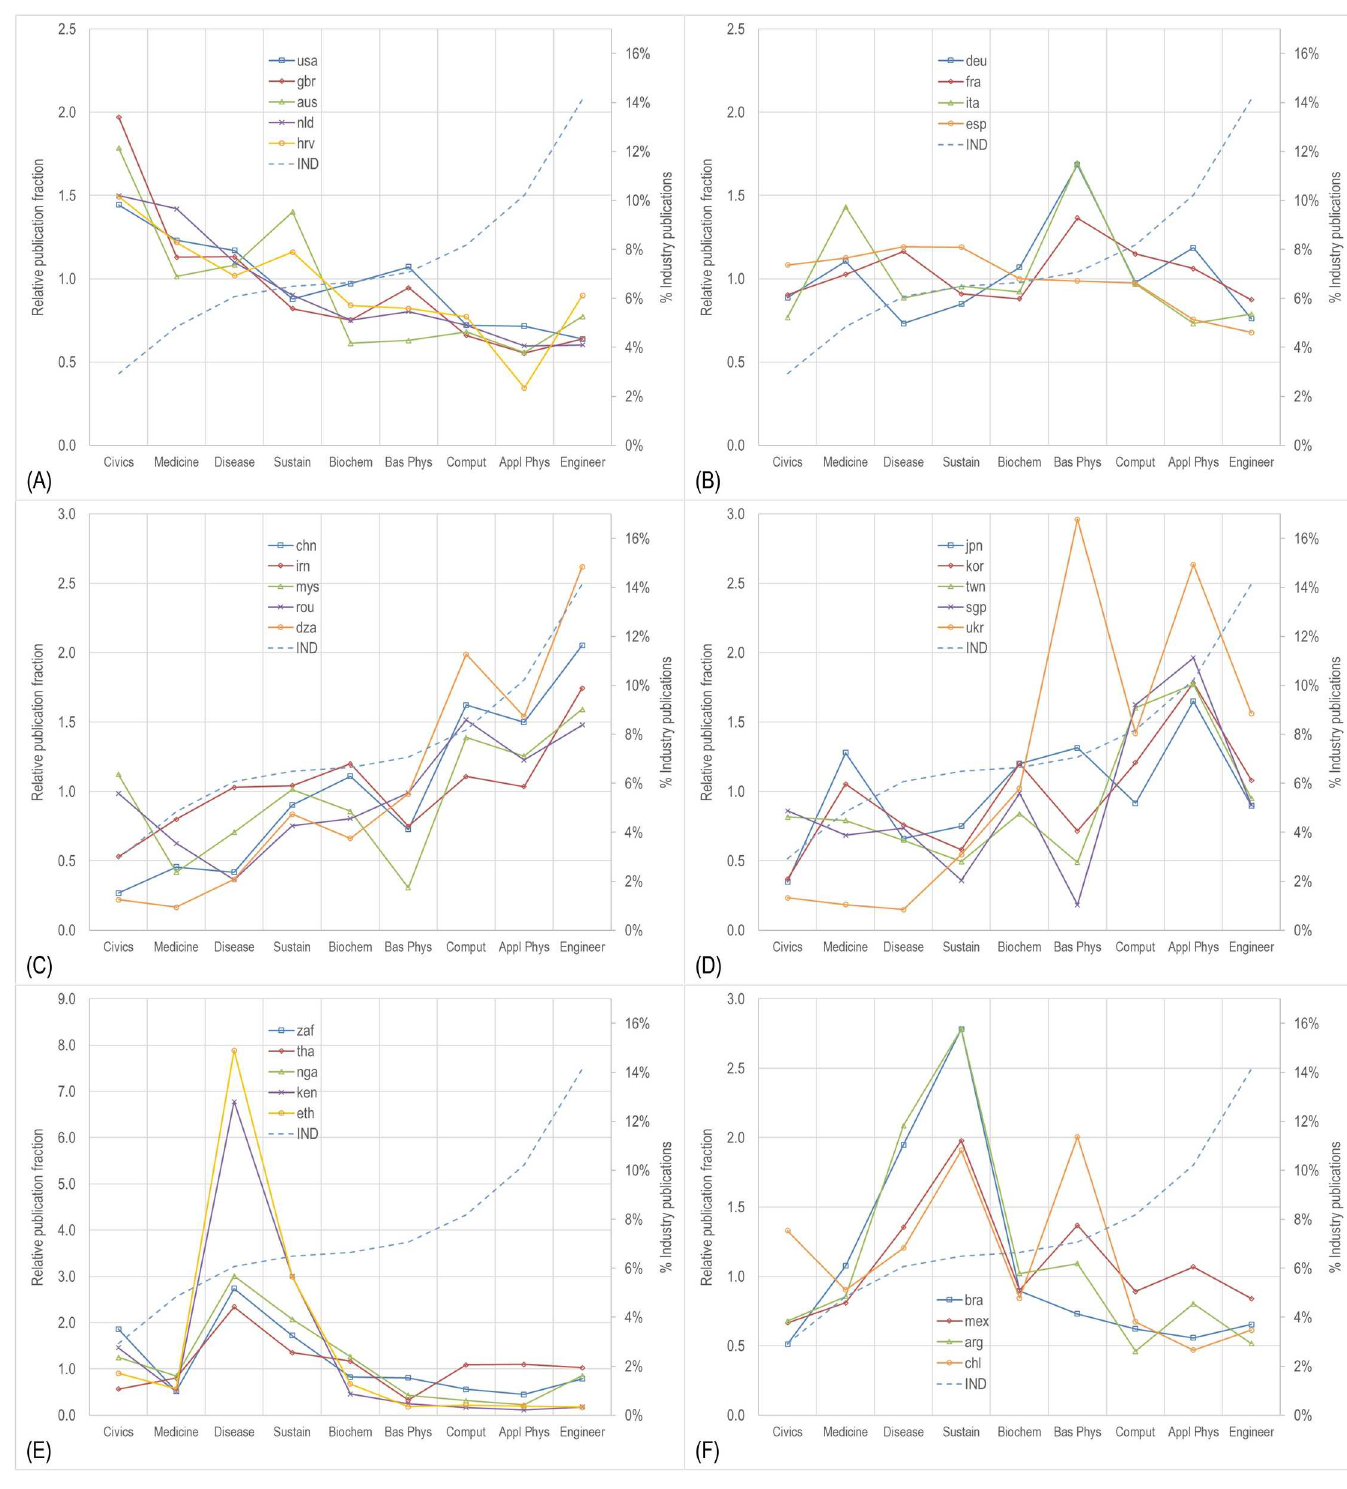
Fig 6. Relativepublication fraction portfolios for six different groups of countries: a) civics portfolio, b) balancedportfolio, c) engineering portfolio, d) nanotechportfolio,e) diseaseportfolio, and f) sustainability portfolio.